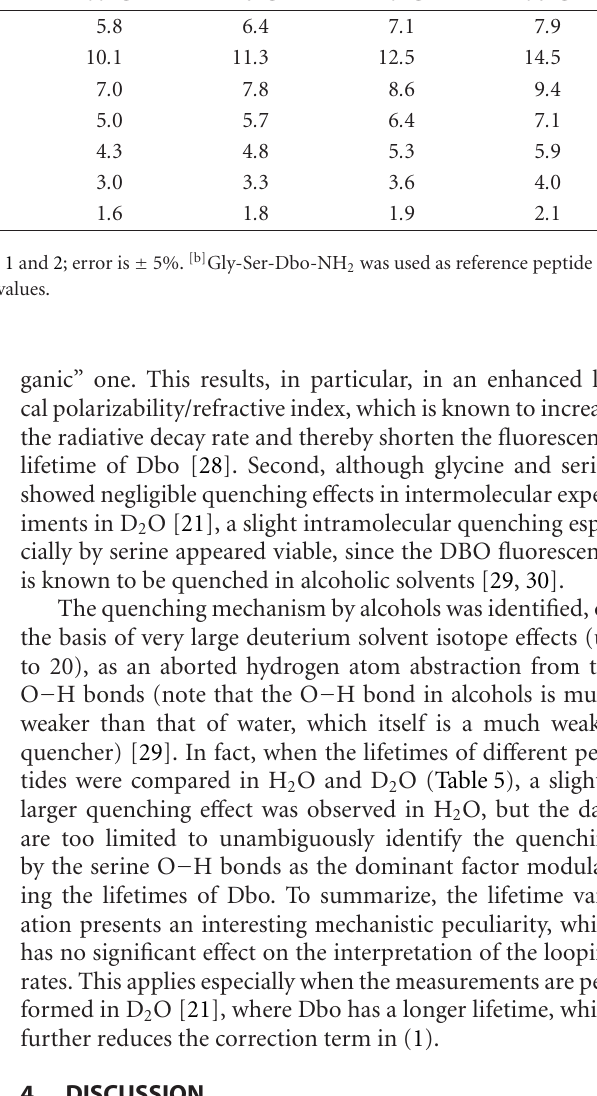
Table 3: Dependence of looping rates on the length of Trp-(Gly-Ser) n -Dbo-NH 2 peptides in D 2 O at di ff erent temperatures. n